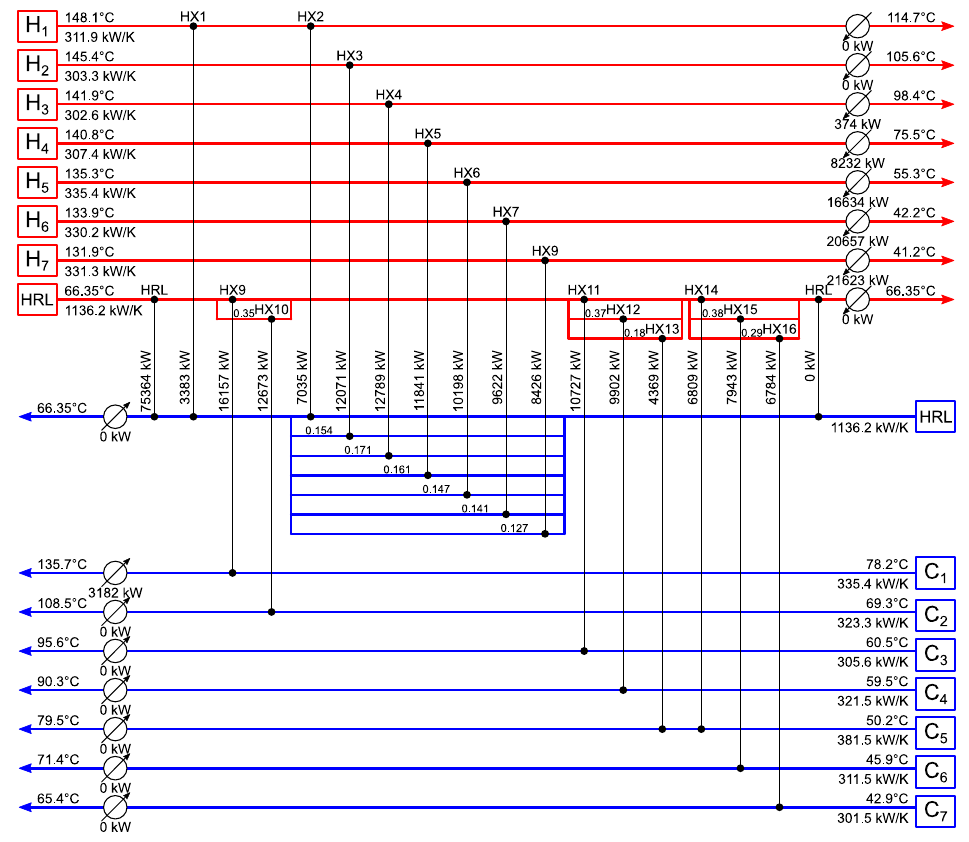
Figure A1. Grid-diagram representation of the optimal HEN configuration found of example 2 including a HRL in the superstructure layout (TAC: 1.54 M$/yr).